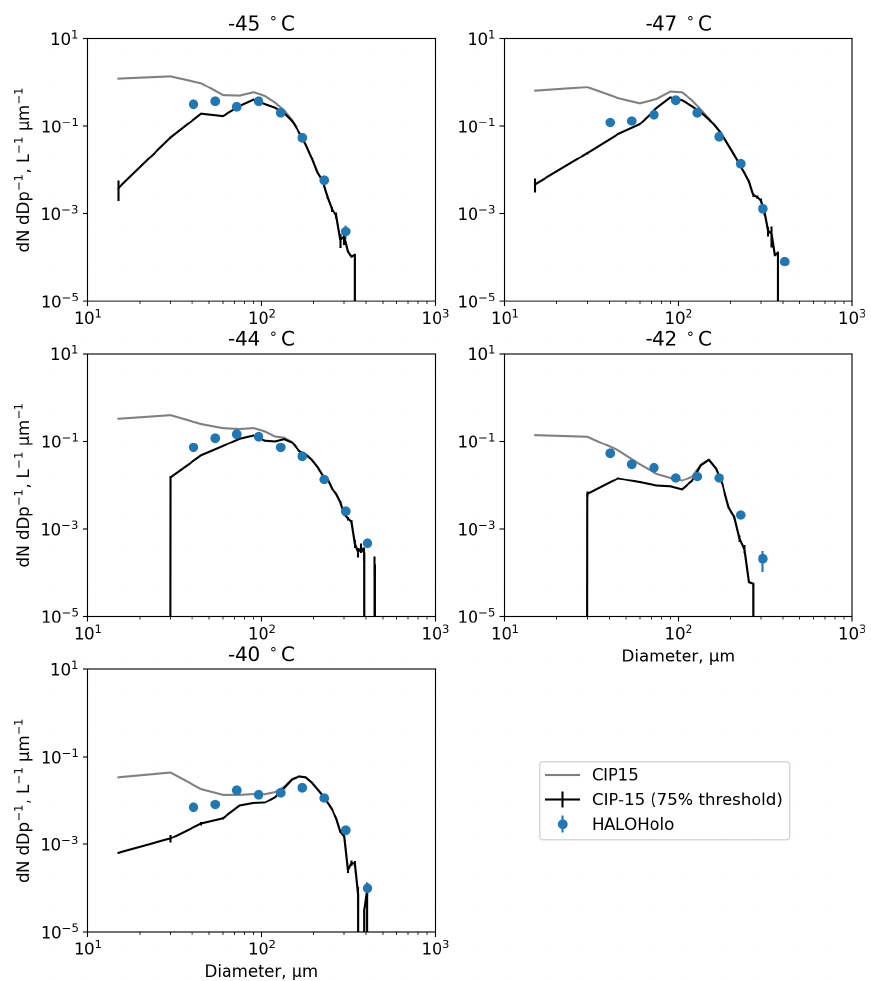
Figure 13. Size distributions from the CIP-15 and HALOHolo for runs between − 47 and − 40 ◦ C on 23 April 2018. The black line shows the CIP-15 size distribution when images are filtered to only include those with at least one pixel at the 75% intensity